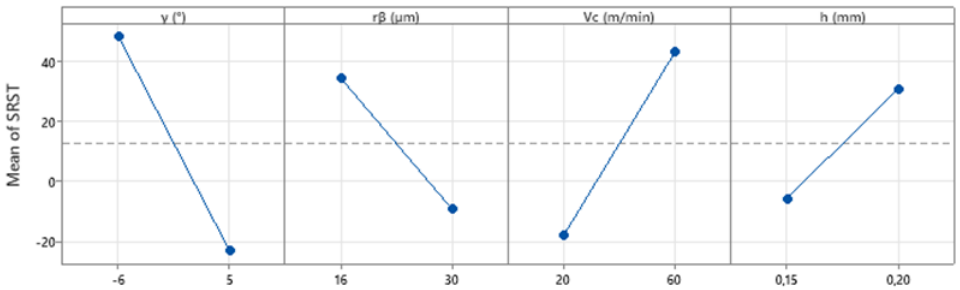
Figure 16. Influence of the cutting parameters on the SRST based on all cutting conditions.